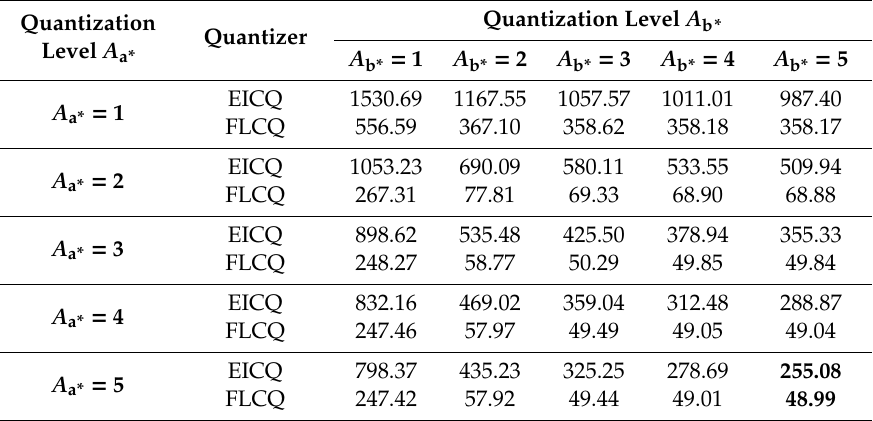
Table A4. The mean square error of the EICQ and FLCQ quantizers on VisTex. Quantization